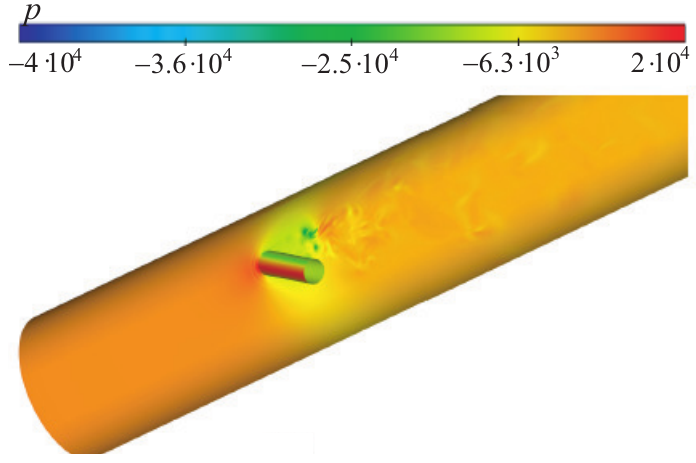
Figure 9. Overpressure field on pipe walls for Re c =